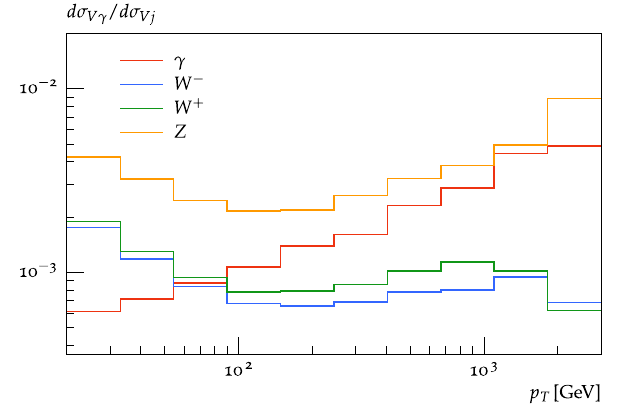
Fig. 3 Ratios of distributions in the vector-boson transverse momenta for pp → V γ versus pp → V j at LO with μ R , F = H T / 2. The vector bosons V = W ± , Z ,γ are on shell and